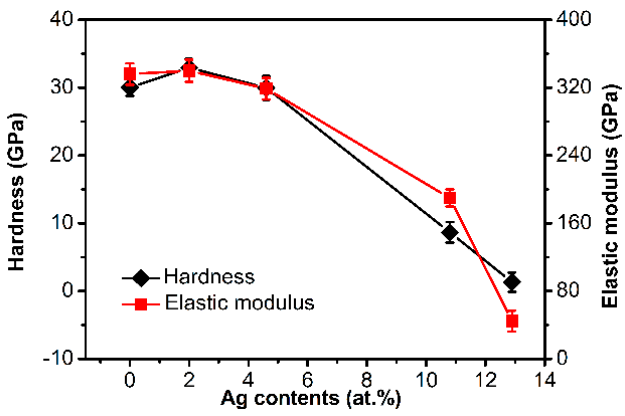
Figure 7. Micro-hardness and elastic modulus of NbCN-Ag composite films with different Ag